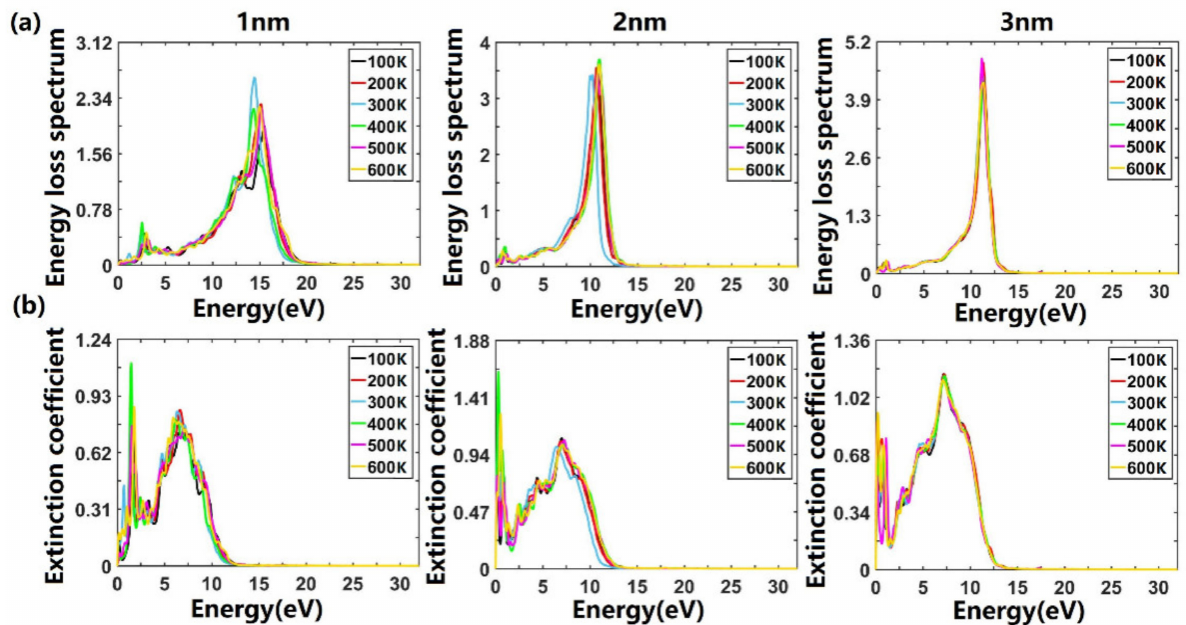
Figure 8. ( a ) Energy loss spectrum and ( b ) extinction coefficient of 1, 2, and 3 nm ITO models at temperatures such as from 100 to 600